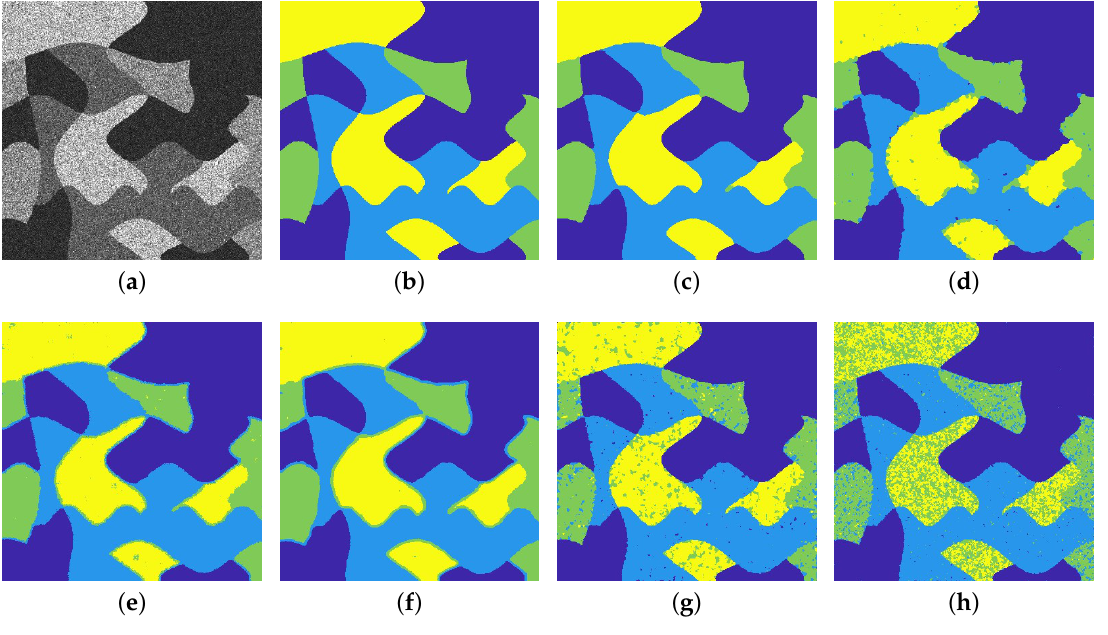
Figure 14. Segmentation results: ( a ) experimental image, ( b ) ground truth, ( c ) proposed, ( d ) FKPFCM [29], ( e ) NSFCM [1], ( f ) ILKFCM [28], ( g ) ALFCM [31], ( h ) CKSFCM [30].